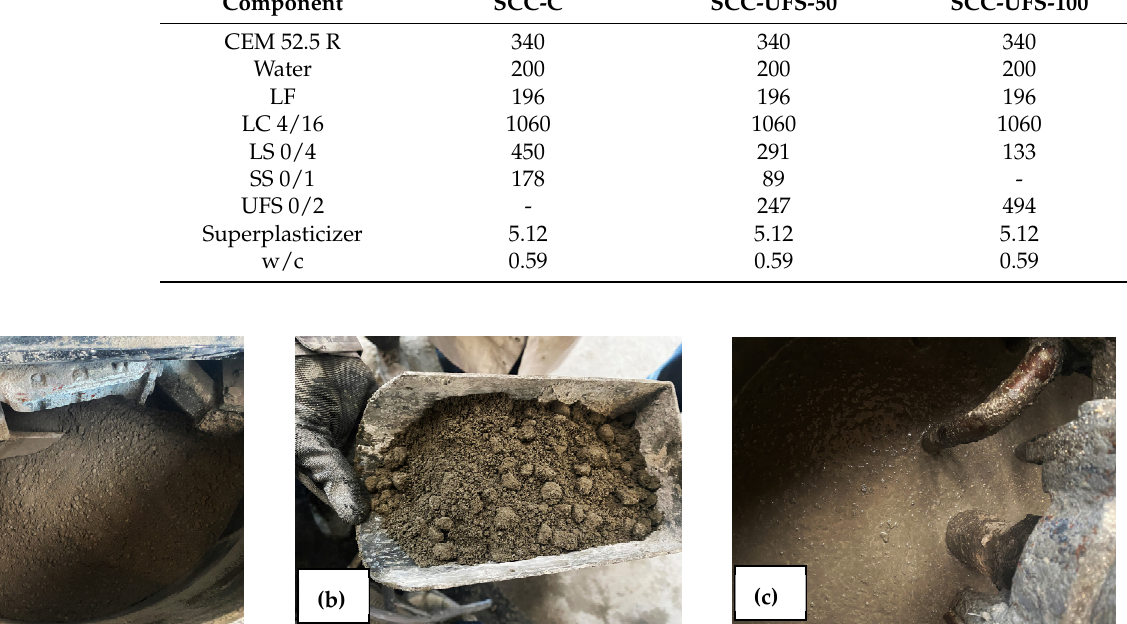
Figure 2. Mix procedure: dry mix of the aggregates ( a ); addition of first part of mixing water ( b ); settling of the SCC mix by 3 min ( c ).